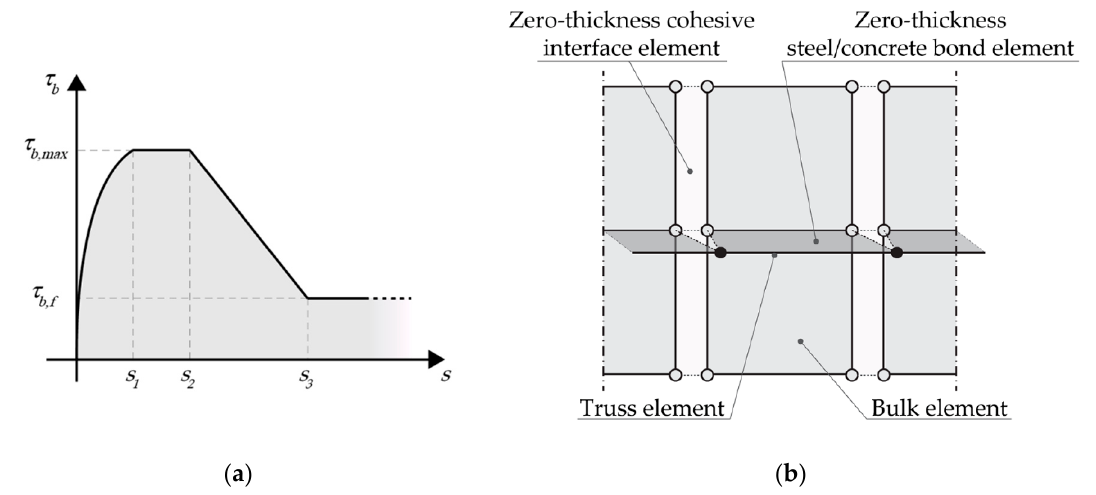
Figure 3. Representation of the steel / concrete interface model: ( a ) bond stress–slip constitutive behavior taken from CEB-FIP Model Code for Concrete Structures 2010 [61]; ( b ) schematic of embedded truss elements and zero-thickness steel / concrete bond elements.